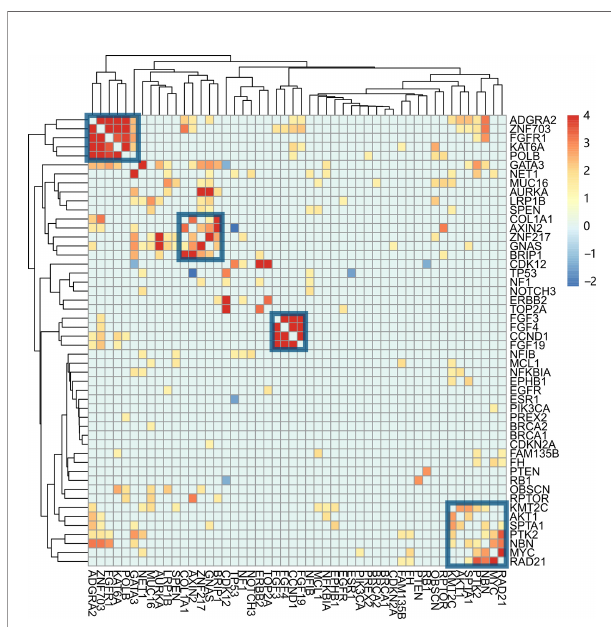
FIGURE 3 | Co-mutation between genes and their association with clinical characteristics. The co-mutation association between each pair of mutations is calculated with Fisher ’ s exact test. The resulting P -value was transformed into a similarity score, -log10( P -value). Genes were hierarchically clustered with Euclidean distance and complete linkage. The four gene clusters are indicated with blue squares. From left to right, they are named clusters 1, 2, 3, and 4.